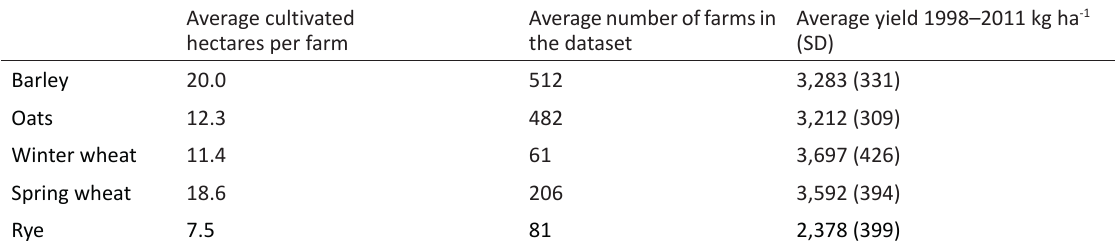
Average number of farms in the dataset